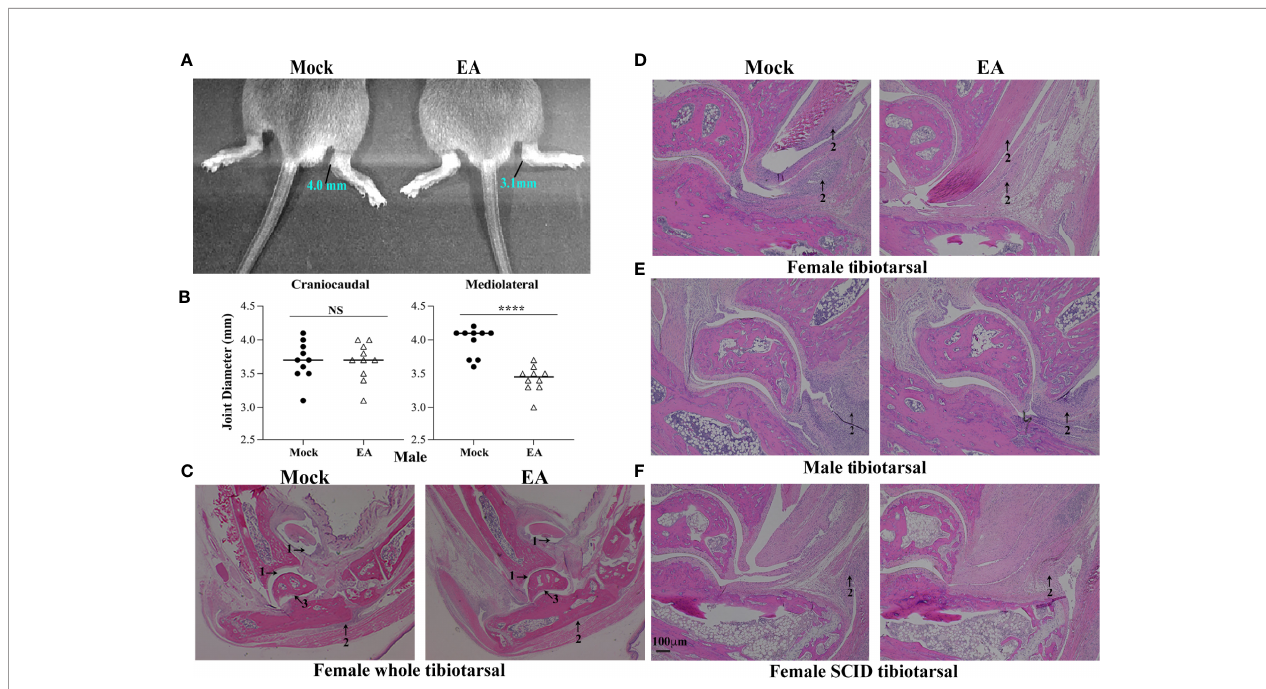
FIGURE 2 | Attenuation of joint in fl ammation and arthritis in EA-treated mice. (A, B) Mediolateral and not craniocaudal measurements of tibiotarsus joints of 10 mice showed a signi fi cant reduction in swelling after EA treatment. Bars indicate median values. (C – F) Severe arthritis in tibiotarsus joint manifested by an increase in synovial space (arrow 1), higher leukocyte in fi ltration (blue stain, arrow 2), and synovial hyperplasia and erosion of cartilage (arrow 3) in composite tibiotarsus image (C) were observed in mock-treated Borrelia burgdorferi -infected mice. In fi ltration of leukocytes as depicted by blue-stained dots reduced in EA-treated mice consistently. Bar in panel F represents a size of 100 µm. EA,